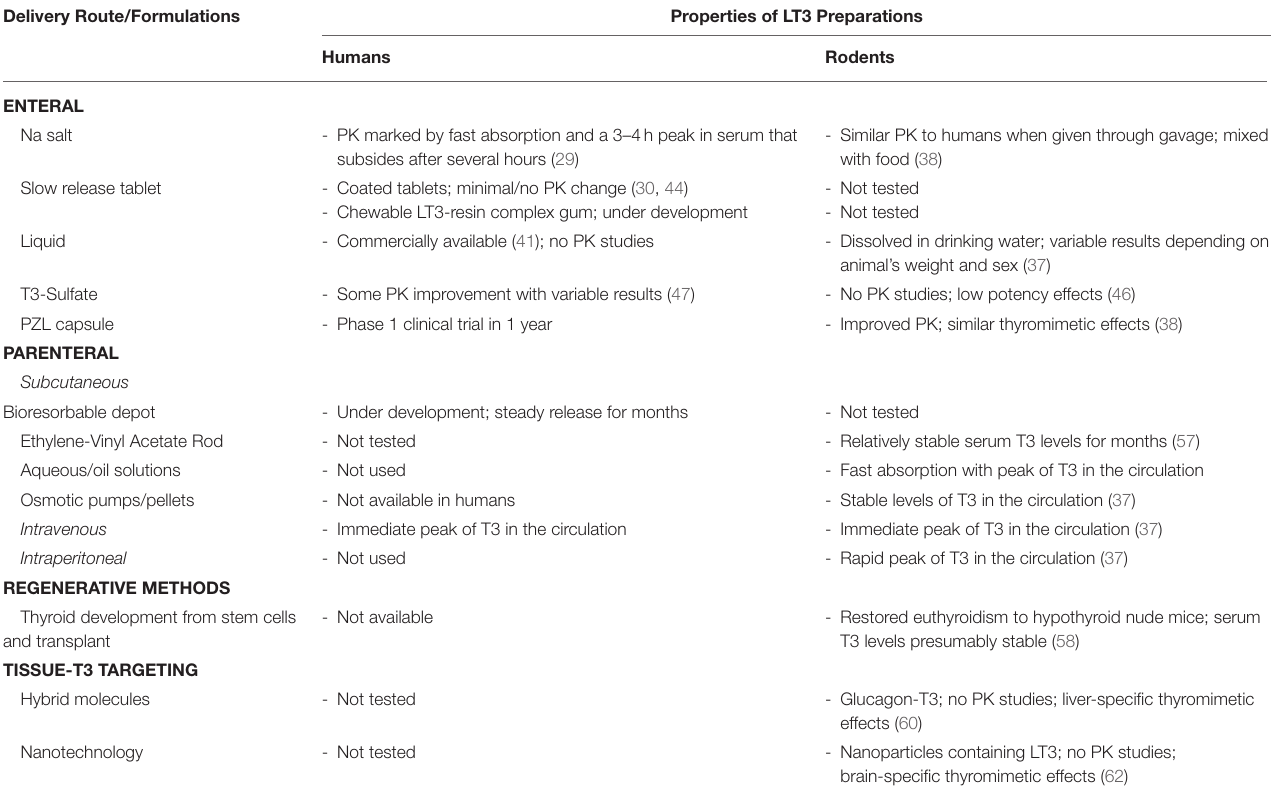
TABLE 1 | Developmental stage of different LT3 products, their main properties and PK studies in rodents and